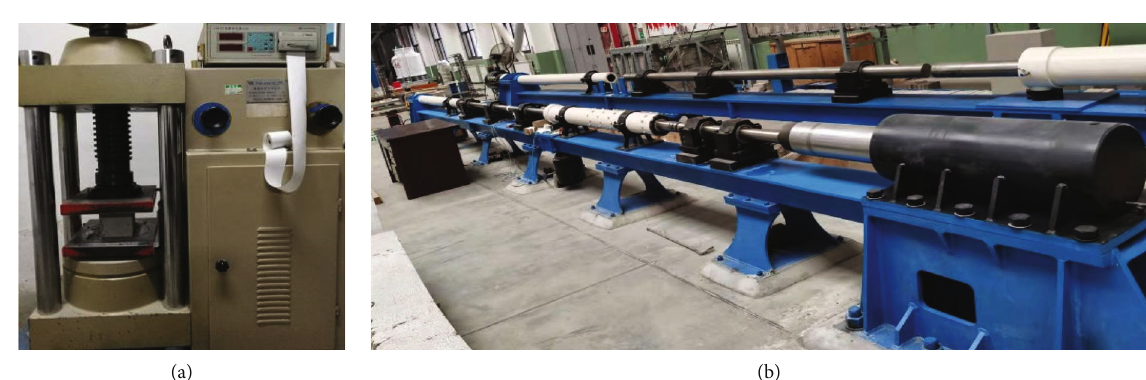
Figure 2: Equipment for quasi-static and impact compression tests: (a) servo press tester; (b) split Hopkinson pressure